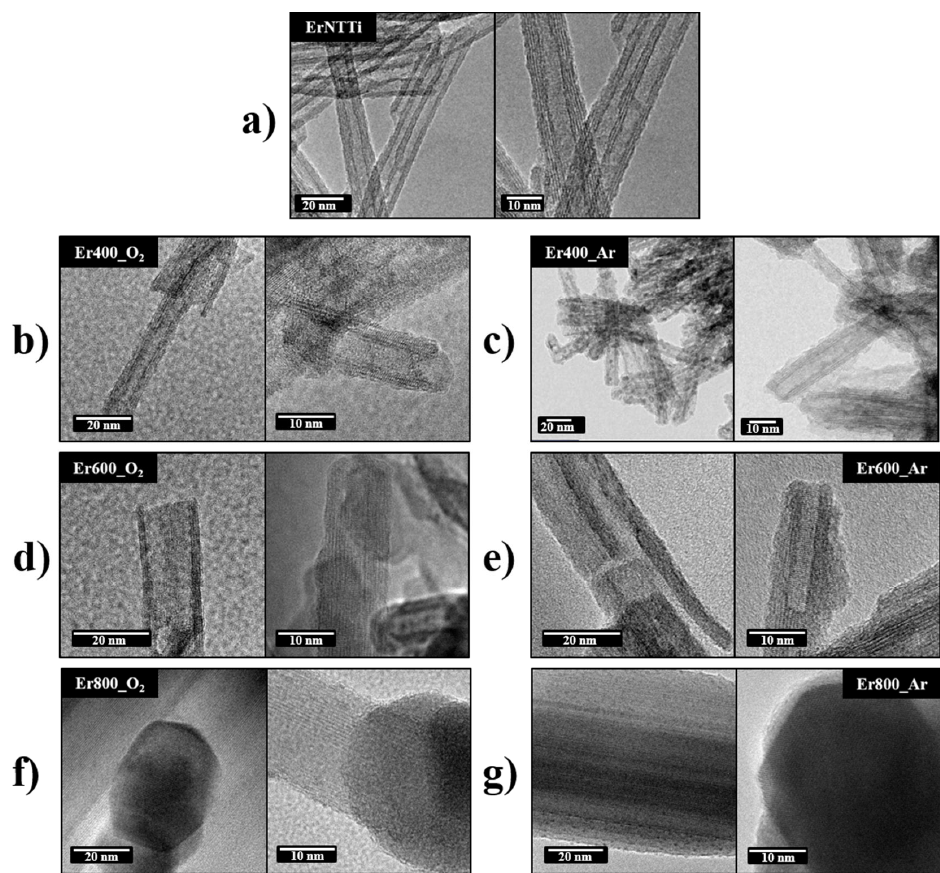
Figure 5. TEM and HAADF-STEM images of ErTNT without treatment ( a ), ErTiNT treated in air, 400 °C ( b ), 600 °C ( d ), 800 °C ( f ), and treated in Argon, 400 °C ( c ), 600 °C ( e ), 800 °C ( g ), showing Er-based NPs and NPs of TiO 2 anatase on the surface of titanate